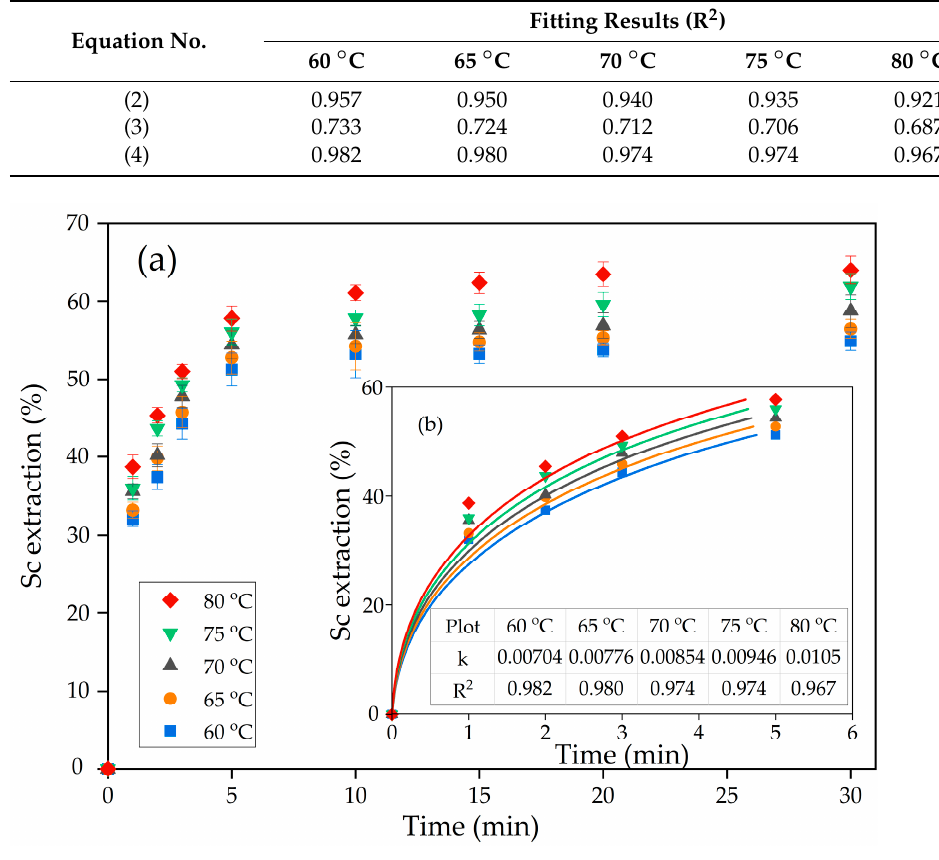
Figure 6. Dependence of: ( a ) the degree of scandium extraction on temperature at L:S ratio 10:1 and pH 2; and ( b ) fitting of experimental data of leaching during the first 5 min to the new shrinking core model.